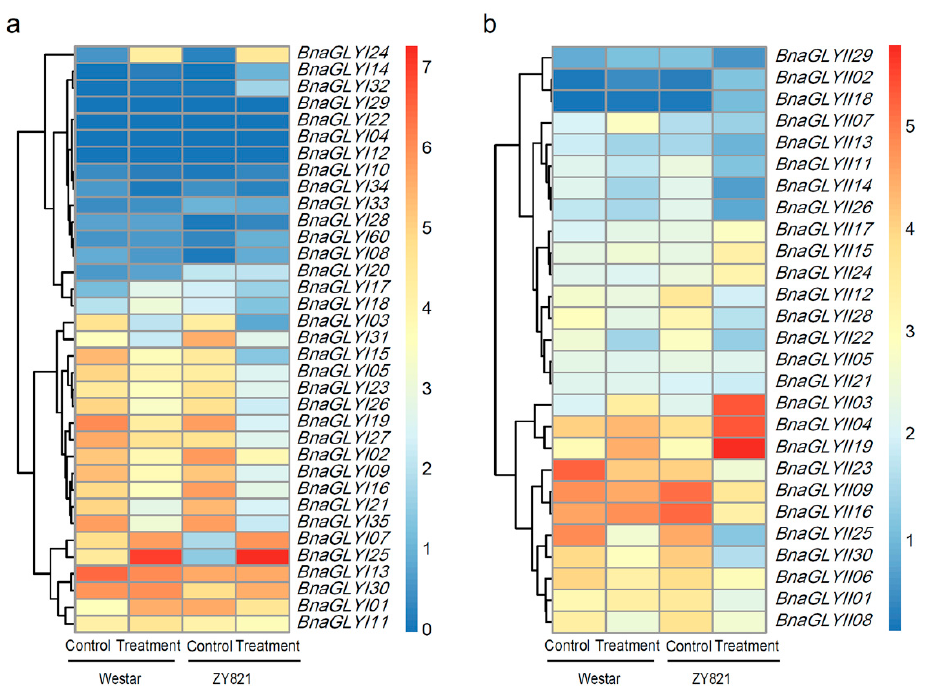
Figure 6. Expression profiles of the BnaGLY genes in response to P. brassicae infection. Relative expression data of available BnaGLYI ( a ) and BnaGLYII ( b ) genes under P. brassicae infection were obtained from BrassicaEDB database (https://biodb.swu.edu.cn/brassica/, accessed on 15 June 2020). The expression level of the inoculated leaves in susceptible (Westar) and tolerant (ZY821) genotypes were analyzed. Note: CK: Control condition; TR: Treatment under P. brassicae infection.